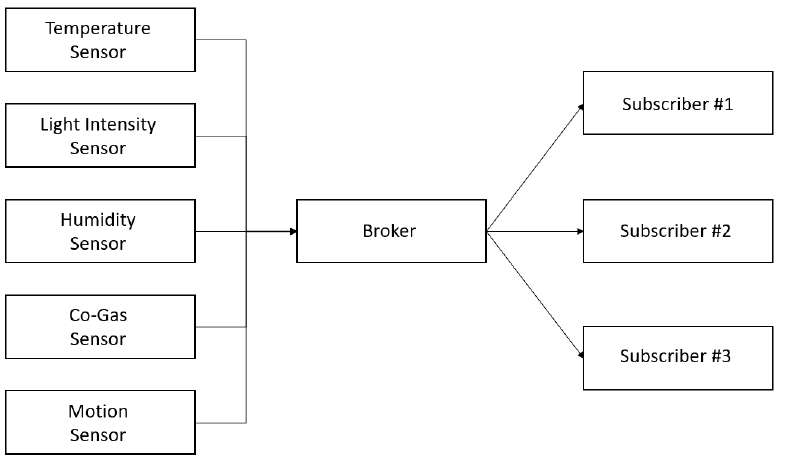
Figure 2. MQTT system structure.